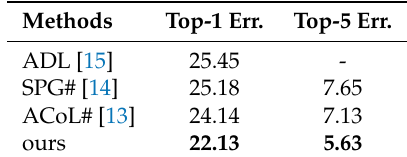
Table 1. Classification error (%) on the CUB-200-2011 test